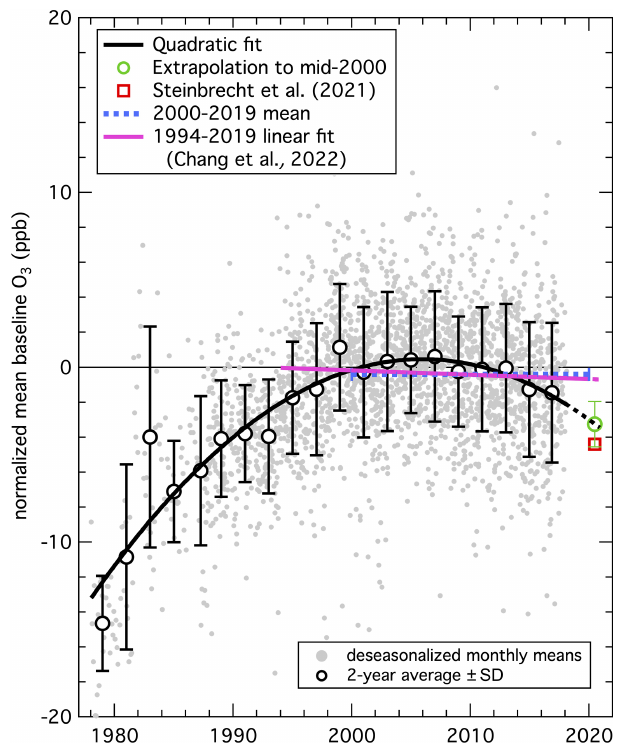
Figure 1. Baseline ozone concentrations at northern midlati- tudes over 4 decades. Gray points are normalized, deseasonalized monthly mean northern midlatitude data, open circles with error bars are 2-year means with standard deviations of the gray points, and the solid black curve is a quadratic polynomial fit to the gray points (Parrish et al., 2020). The dashed black line extrapolates the quadratic fit to mid-2020. The red square and green circle indi- cate estimates of the year 2020 annual mean from Steinbrecht et al. (2021) and the extrapolation of the quadratic fit, respectively; the error bars on the green circle indicate the estimated 95% con- fidence limit of the extrapolation. The dotted blue bar indicates the 2000 to 2020 mean normalized baseline ozone derived from integra- tion of the quadratic fit. The violet line segment has a slope equal to the weighted mean of the northern midlatitude linear trends for 1994–2019 given in Table 2 of Chang et al. (2022), normalized to the 1994–2018 2-year